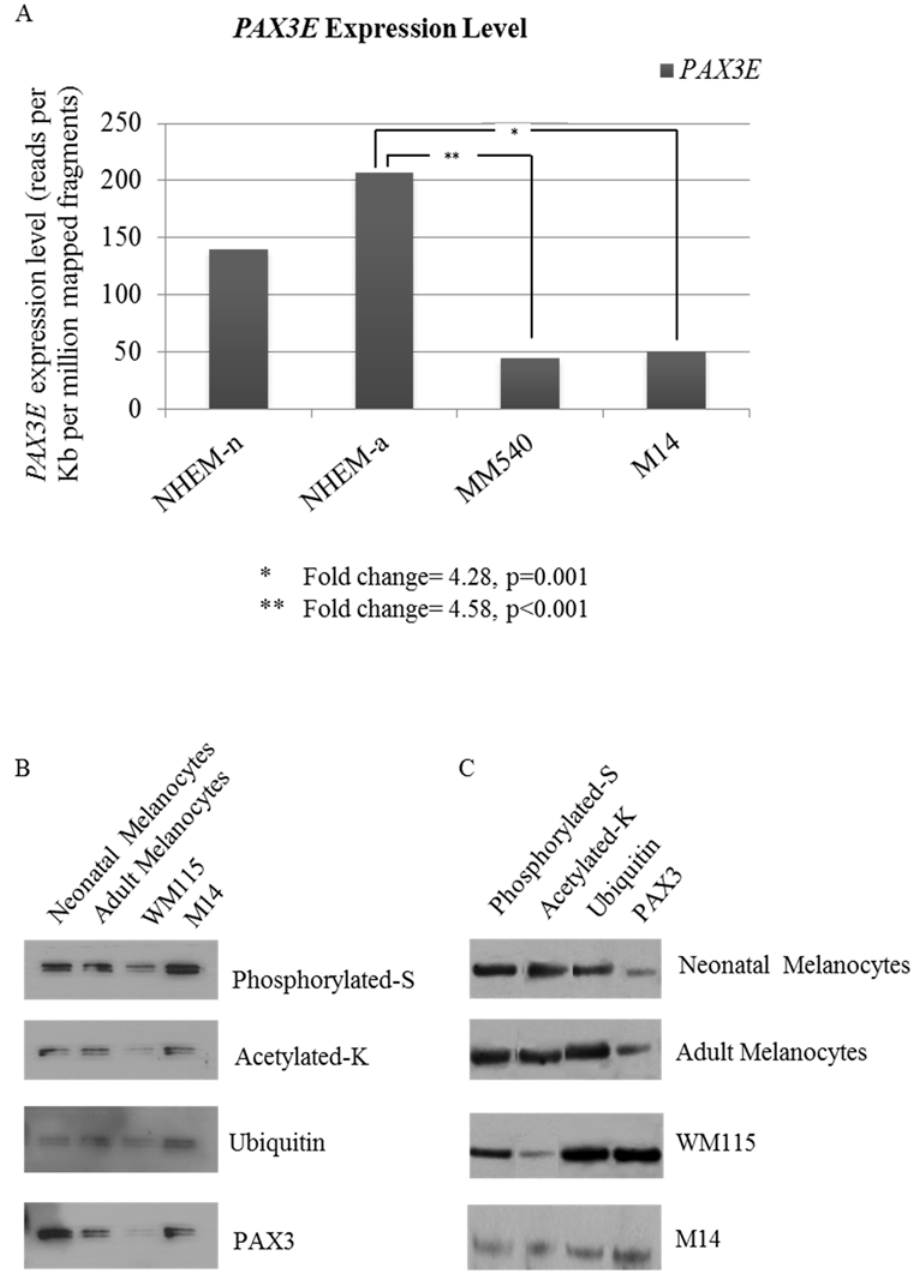
Fig 2. Mechanisms of differential regulation of previously identified downstream target genes of PAX3. A) A comparison of PAX3E expression levels between melanocytes (NHEM-n and NHEM-a) and MM540 and M14 melanoma cell lines measured as number of reads per kilobase of exon model per million mapped fragments. Asterisks ( * , ** ) denote significant differences. B) Immunoprecipitation with Pierce Direct IP Kit, using anti-PAX3 Ab (rabbit monoclonal, Life Technologies and immunoblotting with anti-acetyl-lysine, anti-phosphoserine and anti-ubiquitin. C) Immunoprecipitation (with IgG beads) using anti-phosphoserine, anti-acetylysine, anti-ubiquitin and anti-PAX3 (rabbit polyclonal, Abcam), immunoblotted with anti-PAX3 (mouse monoclonal, DSHB) in human epidermal melanocytes (NHEM-n and NHEM-a (I)) and WM115 and M14 melanoma cell lines.